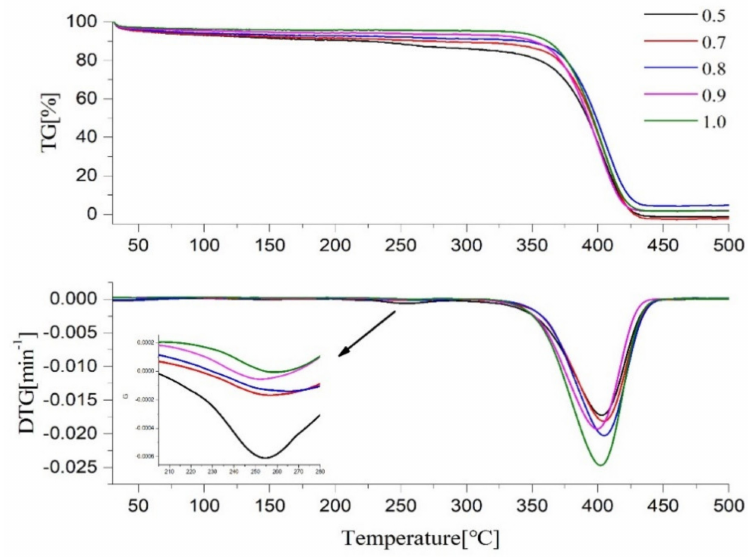
Figure 8. TG curves of PTPET and